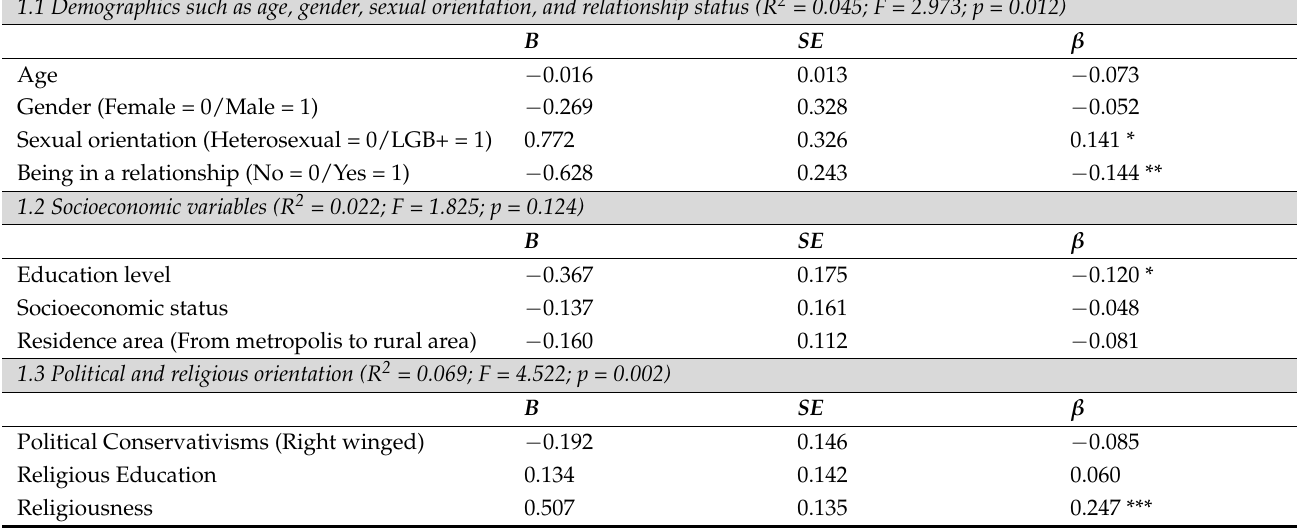
Table 3. Hierarchical multiple regression analyses on sociodemographic variables (n = 333).